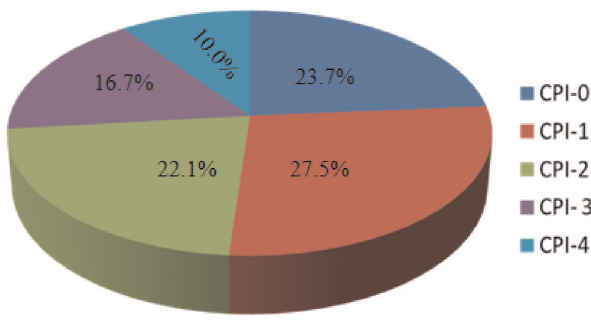
Figure 1. CPI score among the study participants.